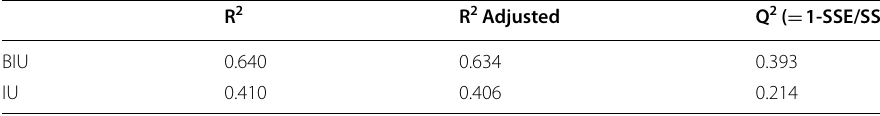
Table 4 R 2 and Q 2 of the Endogenous Variables